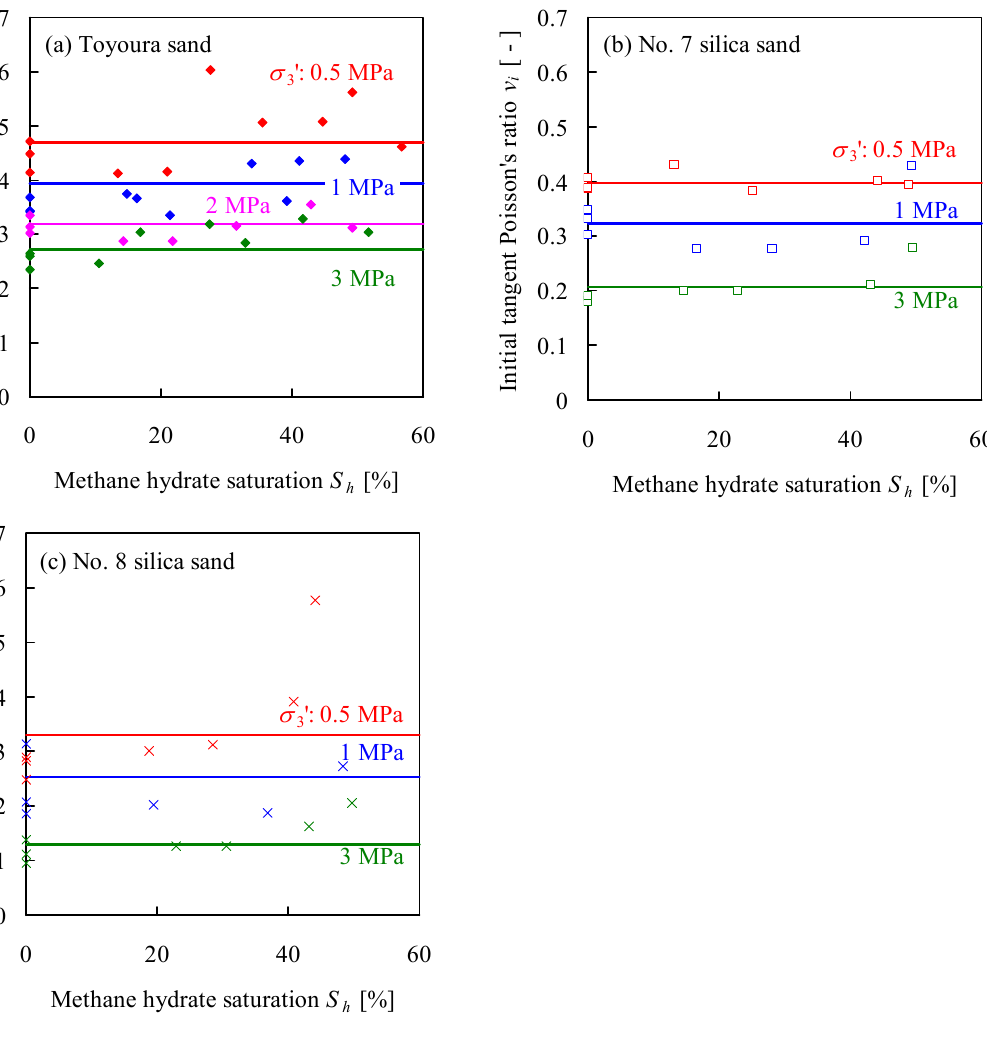
. The solid line is calculated i